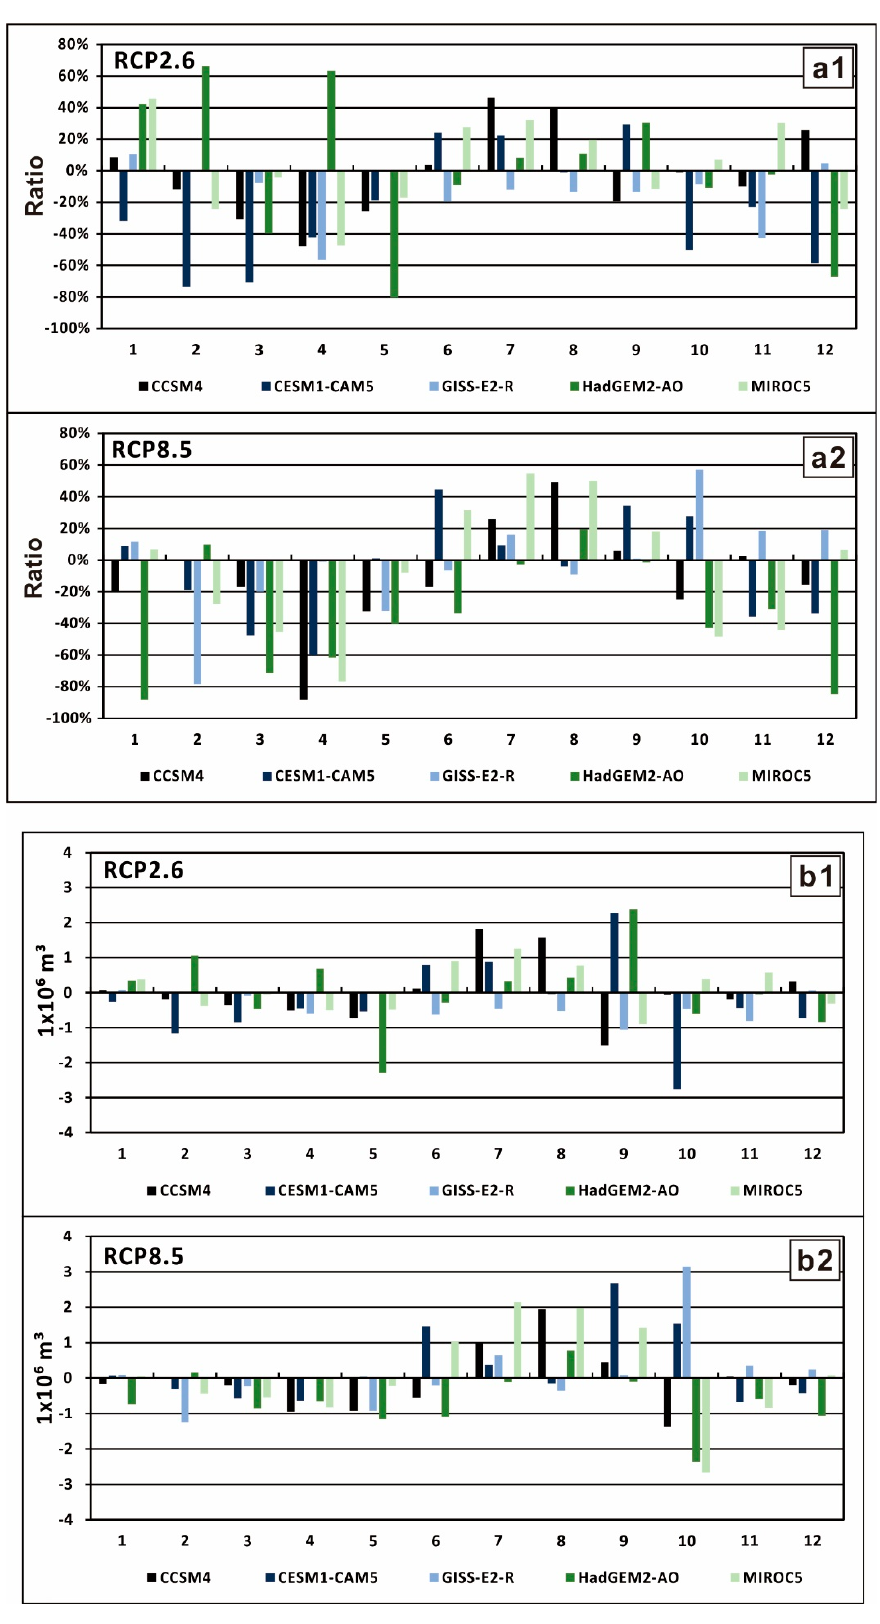
Figure 9. Deviation percentage in ( a1 ) RCP2.6 and ( b1 ) RCP8.5 and gap values in ( a2 ) RCP2.6 and ( b2 ) RCP8.5 between average monthly water yield and the baseline.